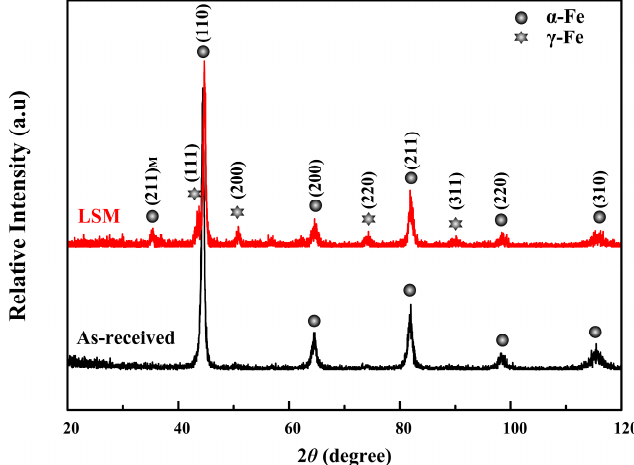
Figure 3. X-ray diffraction (XRD) patterns of as-received H13 steel and laser-affected zone. Figure 3. X-ray di ff raction (XRD) patterns of as-received H13 steel and laser-a ff ected